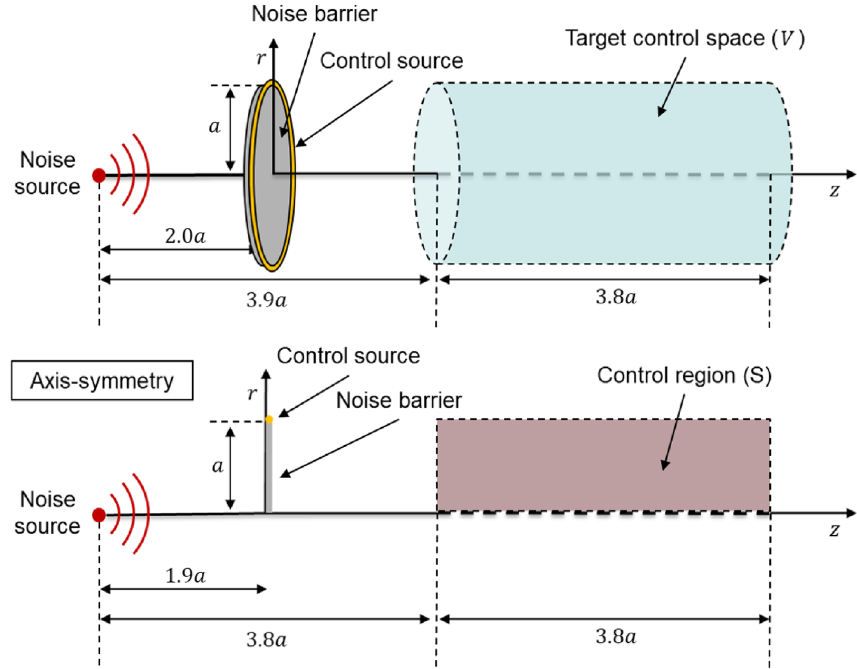
Figure 1. Configuration of the circular active noise barrier (top) and illustration of an axisymmetric structure in two-dimension (bottom). The control source is a circular line source in the prior study. a is the radius of the barrier. V is the target control space, and S is the cross-section of the axis-symmetric